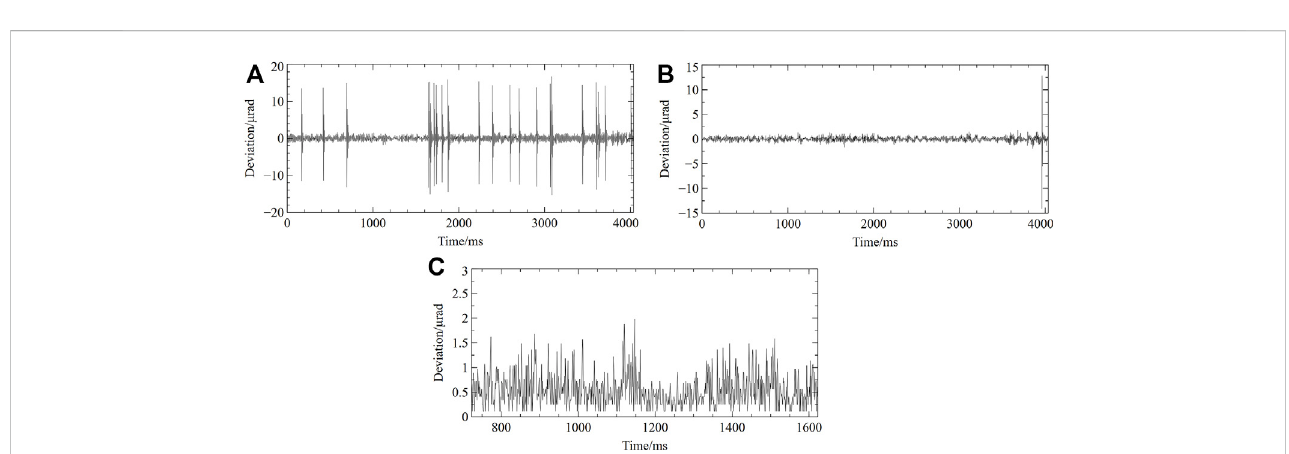
FIGURE 6 Activebeam-pointingstabilizationcontrol systemworkinginaclosed loopintheSGII-UP-Petawatt – picosecondsystem: (A) Pointing fl uctuations inthe vertical direction; (B) Pointing fl uctuations in the horizontal direction; (C) Pointing fl uctuations from 723 ms to 1,624 ms in (A)